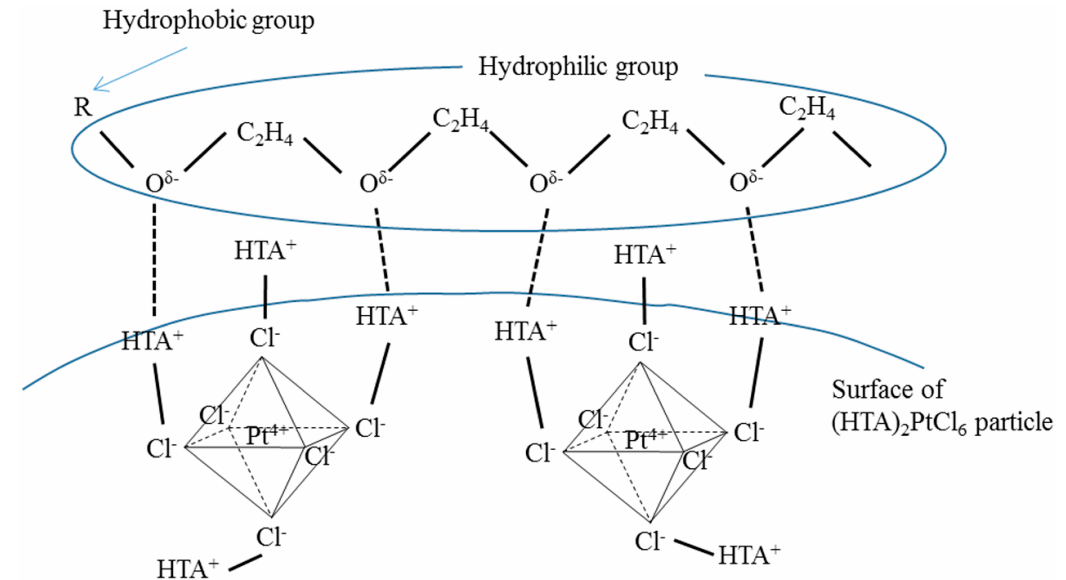
Figure 1. Effect of immobilization time on Pt content of Pt-loaded zeolite catalysts prepared using w/o microemulsion. ● Pt content. ○ Pt recovery. □ Support recovery .